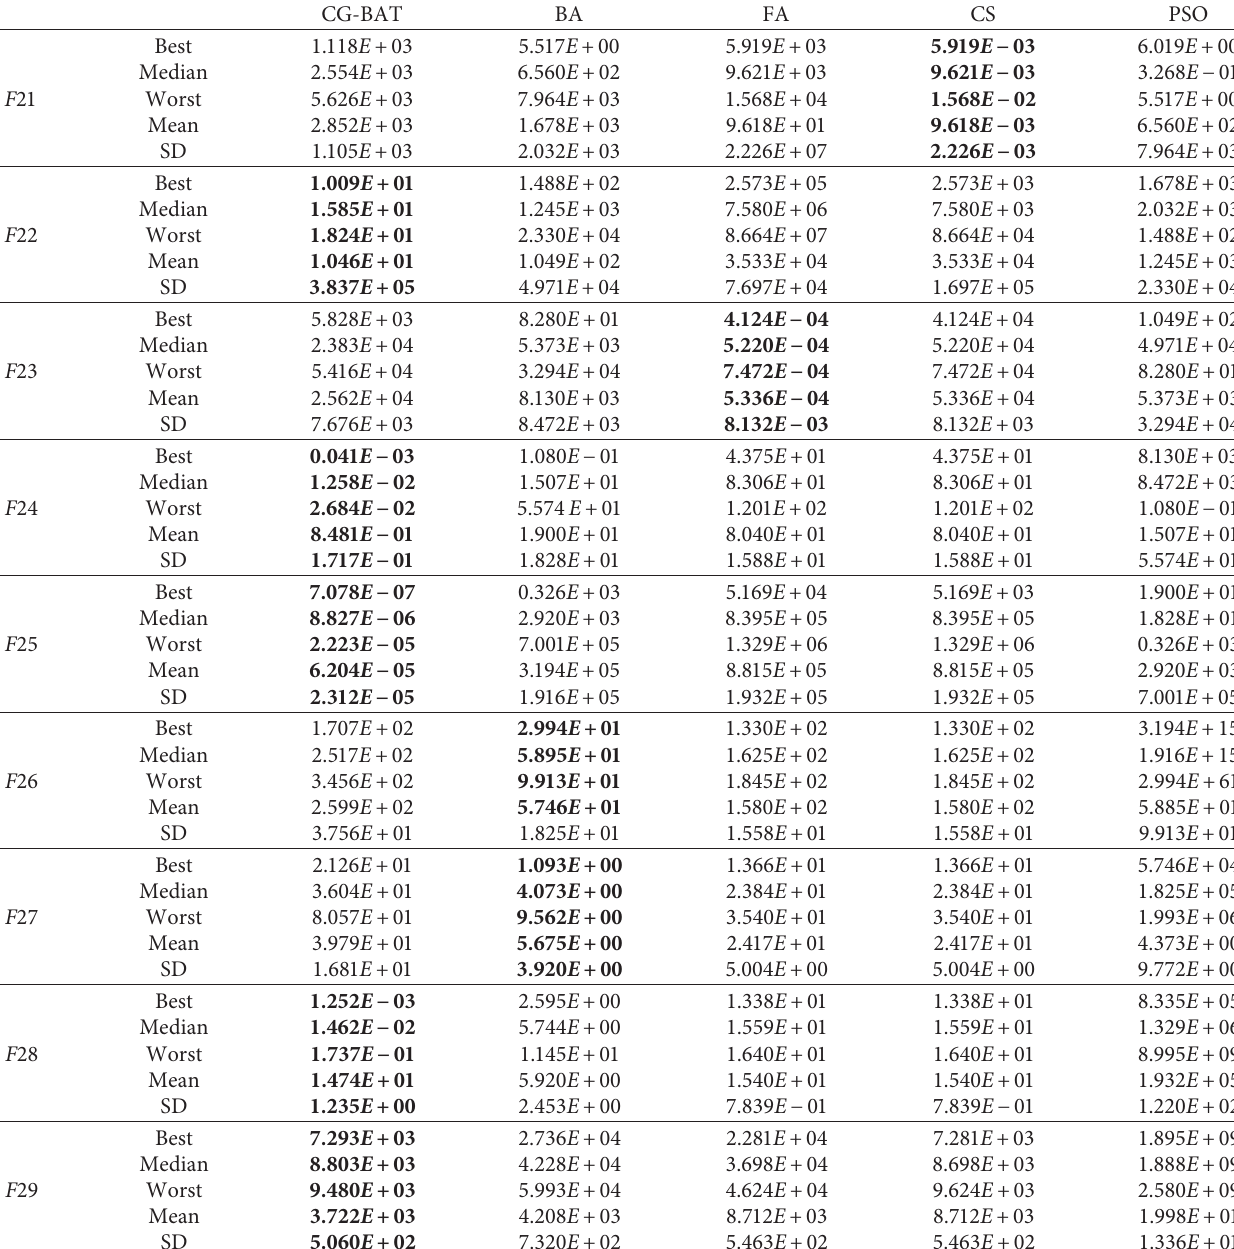
Table 4: Comparison between CG-BAT and classical algorithm on benchmark functions ( F 21 ∼ F